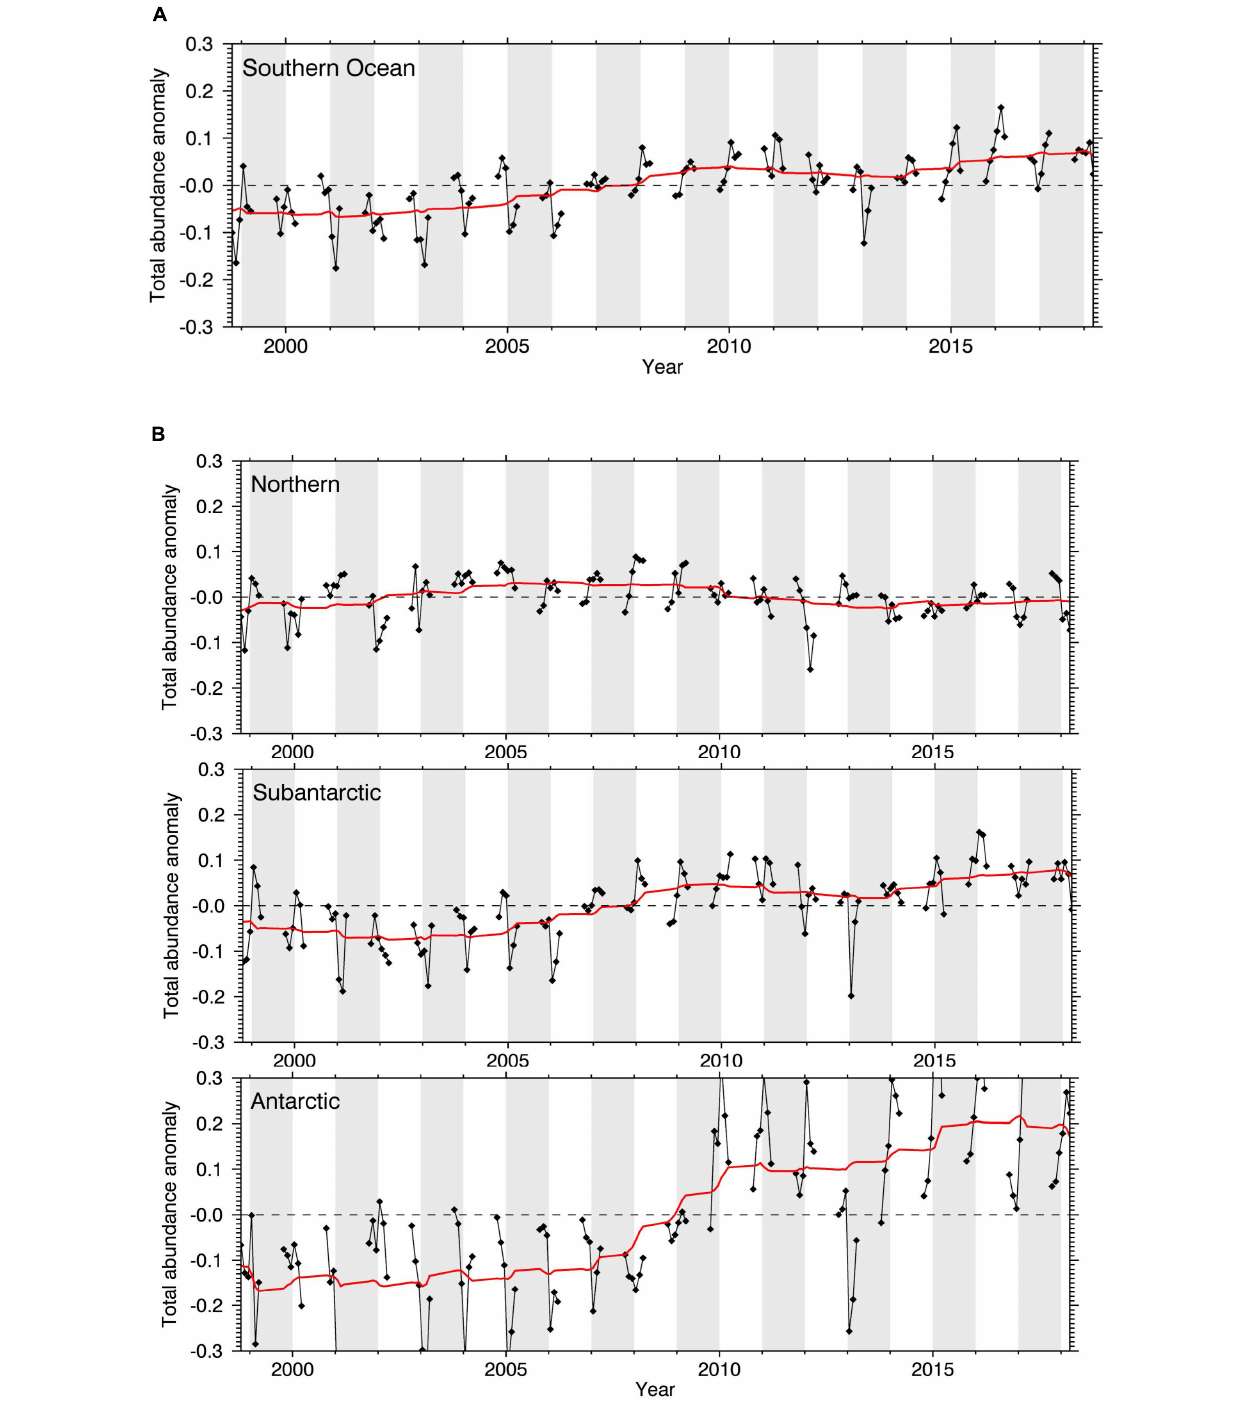
FIGURE 6 | Time series of change in environmental suitability for total zooplankton abundance, i.e., Euphausiidae, Copepoda (Calanoida and Oithona similis ), and pteropods, from the combined Boosted Regression Tree model of Pinkerton et al. (2020) for the Southern Ocean Marine Ecosystem Assessment for the Southern Ocean (MEASO) (A) study area, (B) Sectors. Time Series change for each individual MEASO Zones and Area are given in Figure 7 and Supplementary Figure 3 , respectively. The environmental suitability anomaly (difference from the monthly climatological value) is shown for each month over period 1998–2018. Gray shading indicates calendar years. Black points and lines are monthly anomalies (differences from long-term monthly means). Red lines are smoothed changes (4-year running